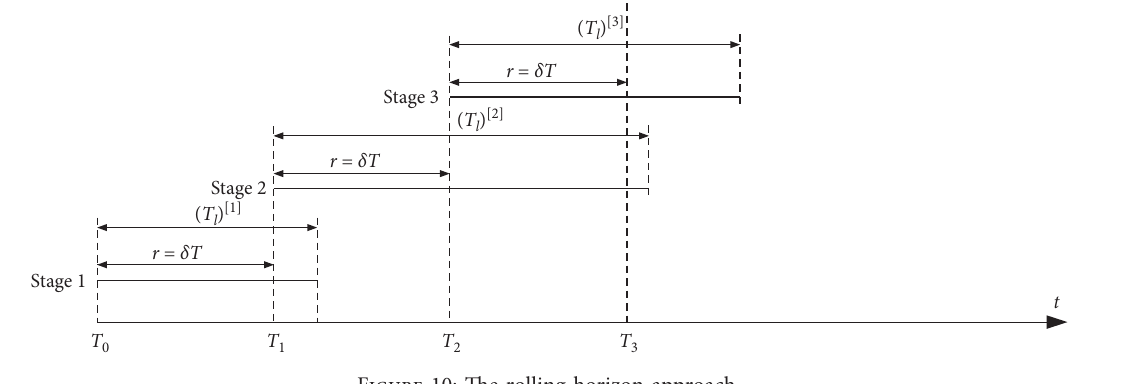
Figure 10: The rolling horizon